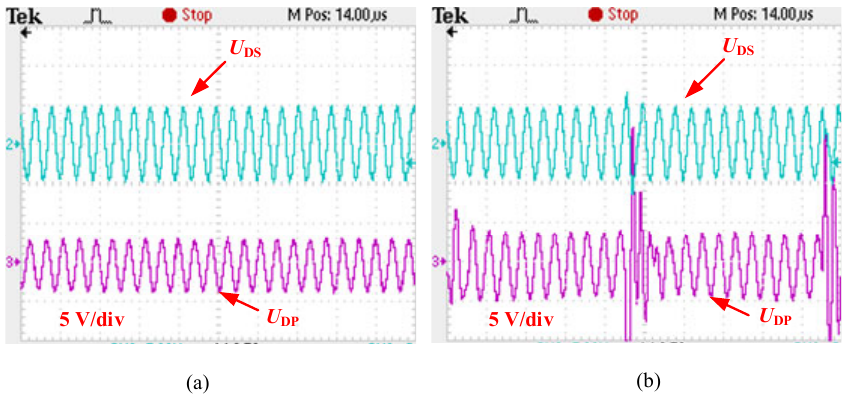
Figure 7. The backward data transfer waveform when ( a ) there is no power resonance circuit and ( b ) there is power resonance circuit.